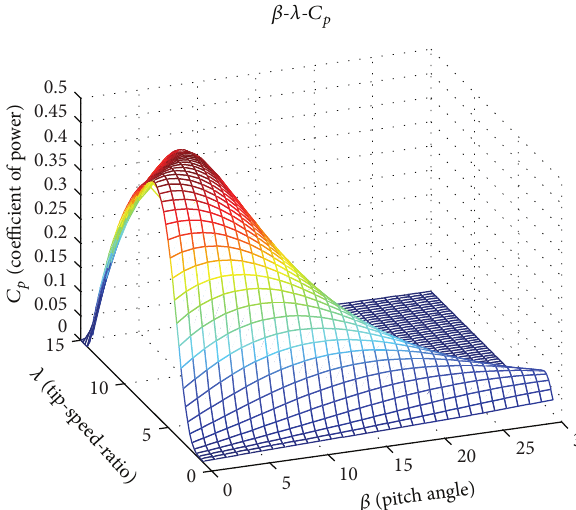
Figure 1: Power coefficient 𝐶 𝑝 with respect to tip-speed-ratio and pitch angle [20].